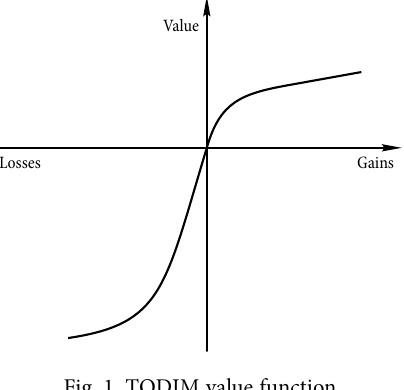
Fig. 1. TODIM value function Source : Gomes and Rangel (2009: